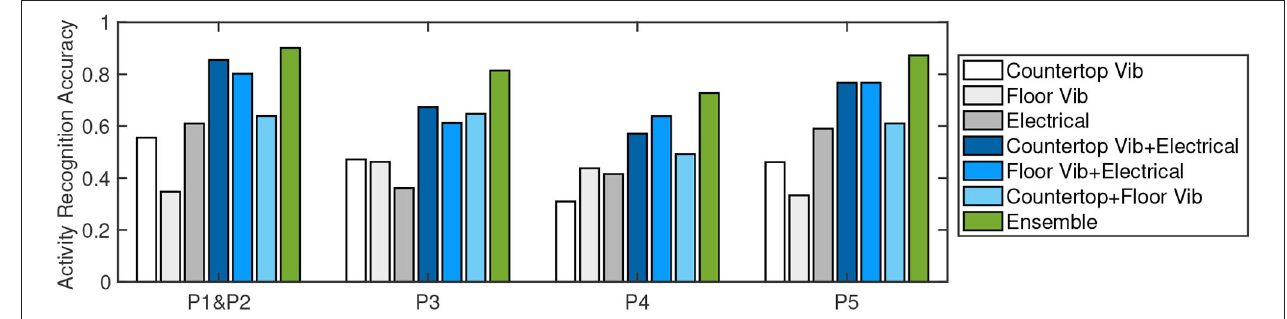
FIGURE 13 | ADL recognition accuracy when training on two persons’ data ( P 1 & P 2 ) and testing on different people ( P 3 , P 4 , and P 5